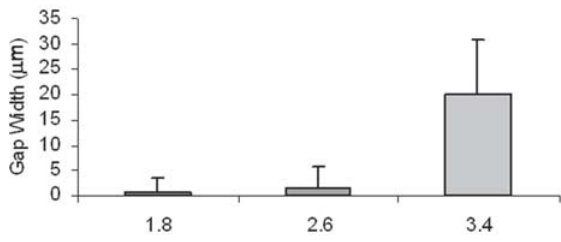
FIGURE 3- Mean gap width (µm) for C-factor as an independent factor (vertical bar represents the standard